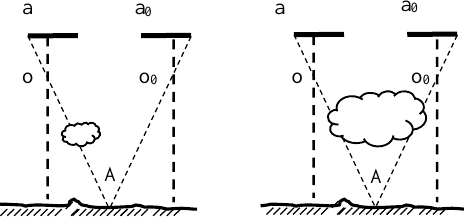
Figure 2. Different size of clouds in